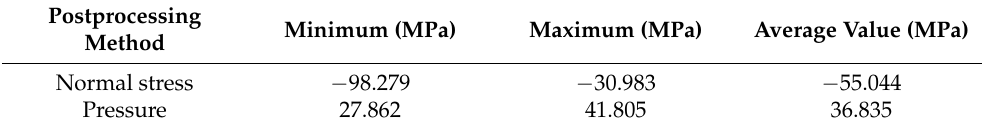
Table 5. Results of geometric interference setting